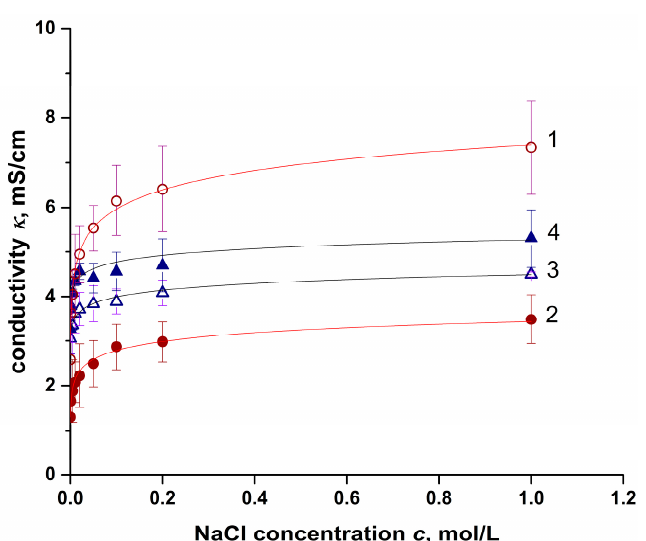
Figure 5. Concentration dependence of the mean electrical conductivity of the ion-exchange mem- branes from both batches. Membranes: 1–MK-40, 2–MA-41, 3–Ralex CM, 4–Ralex AMH. branes from both batches. Membranes: 1—MK-40, 2—MA-41, 3—Ralex CM, 4—Ralex